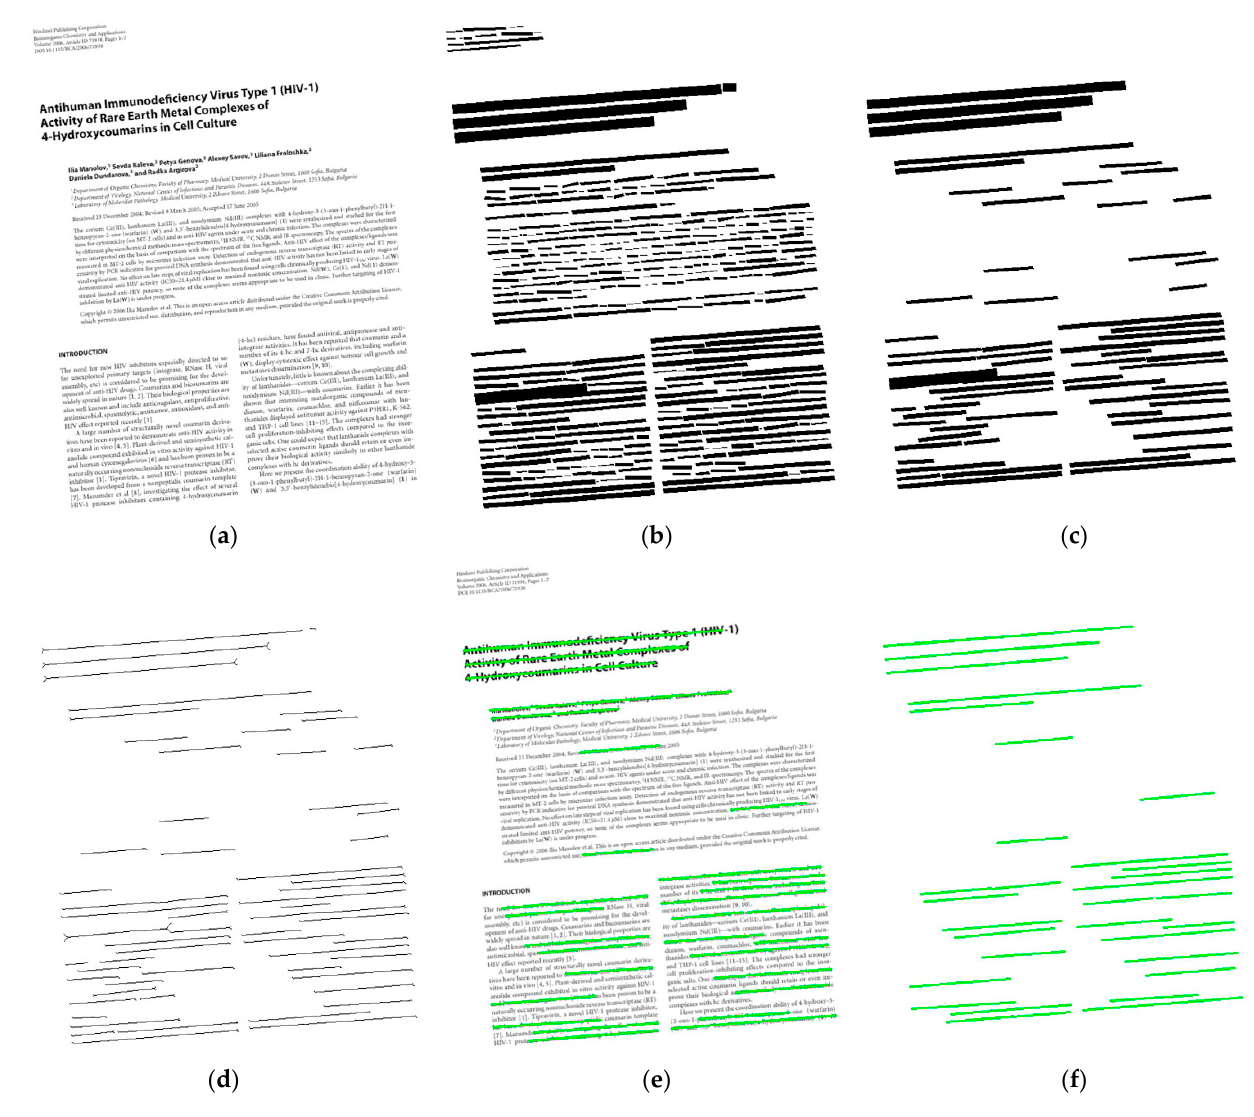
Figure 4. Skeleton line detection process. ( a ) Original image. ( b ) Minimum bounding rectangle image. ( c ) Filtered minimum boundary rectangular image. ( d ) Text line skeleton. ( e ) Line detection results based on text skeleton. ( f ) Text skeleton lines.